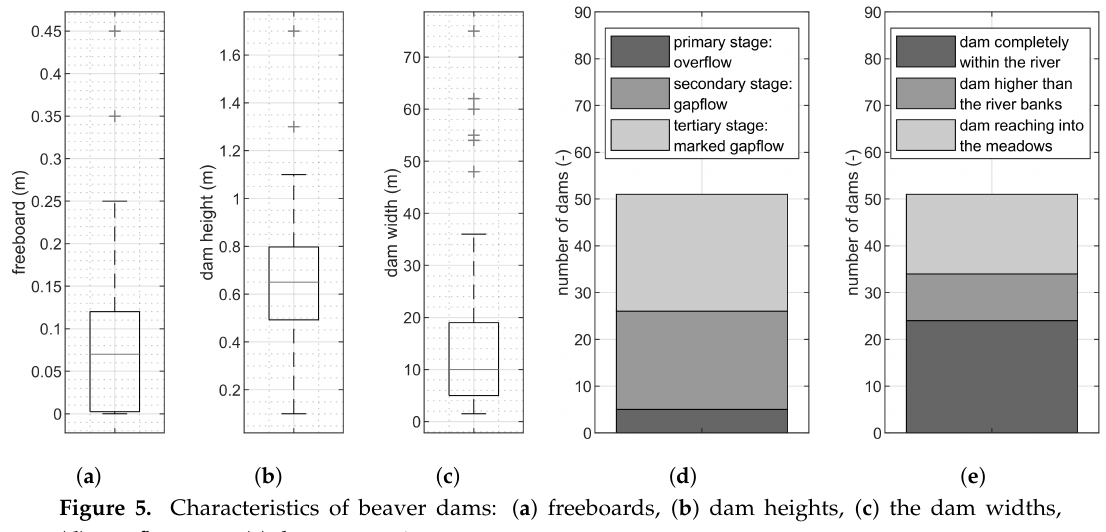
Figure 5. Characteristics of beaver dams: ( a ) freeboards, ( b ) dam heights, ( c ) the dam widths, ( d ) overflow type, ( e ) the construction